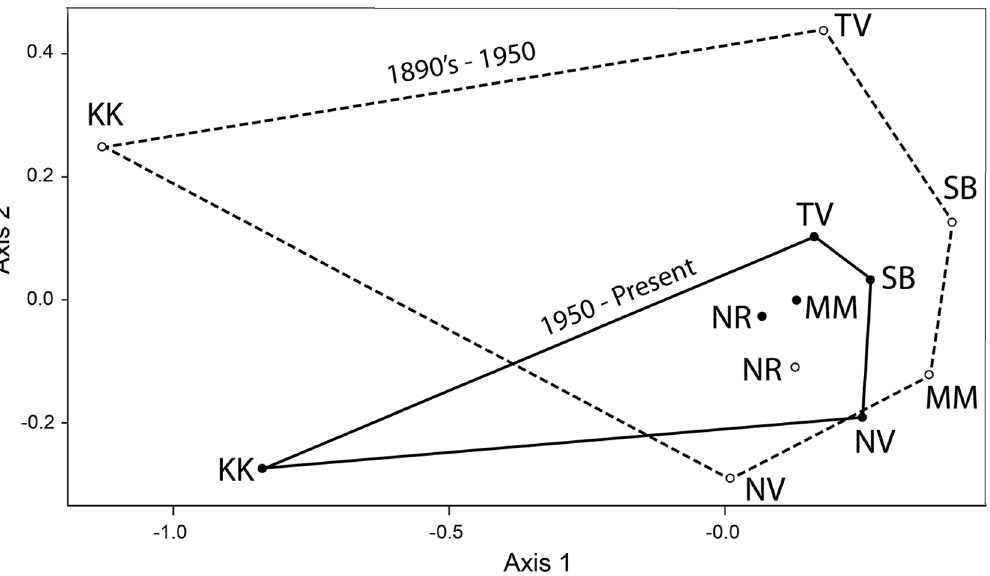
overall spread (polygons) decreases (area of historical hull=0.629; modern hull=0.155; Stress (av. of 4 runs)=0.0746). Key: KK=Kakamega, MM=Maasai Mara, NV=Naivasha, NR=Nairobi, SB=Samburu, TV=Tsavo.